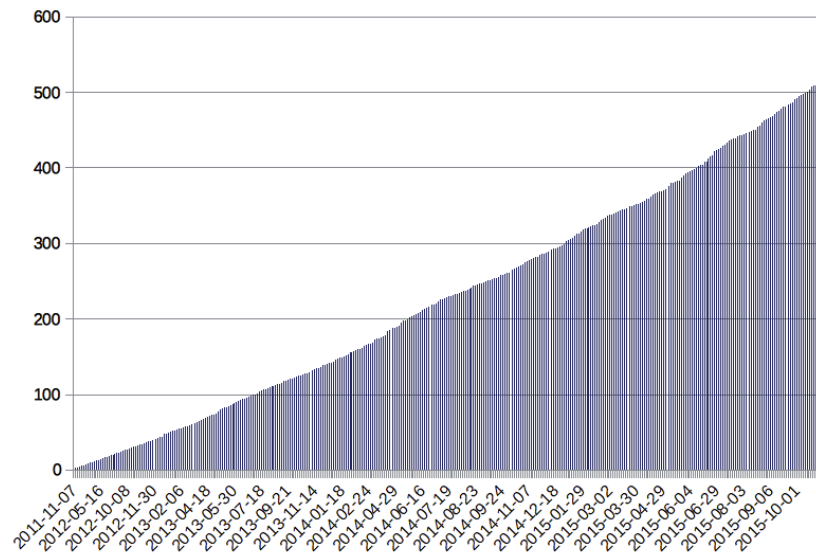
Figure 1. Cumulative number of workshops.